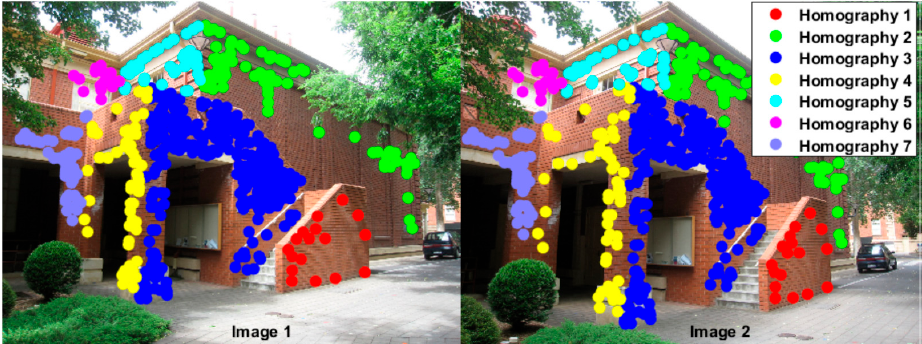
( a ) Multi-homography matrix fitting data set “johnsonb” without outliers. Figure 5. Cont